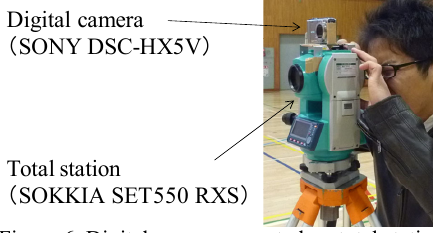
Figure 6. Digital camera mounted on total station